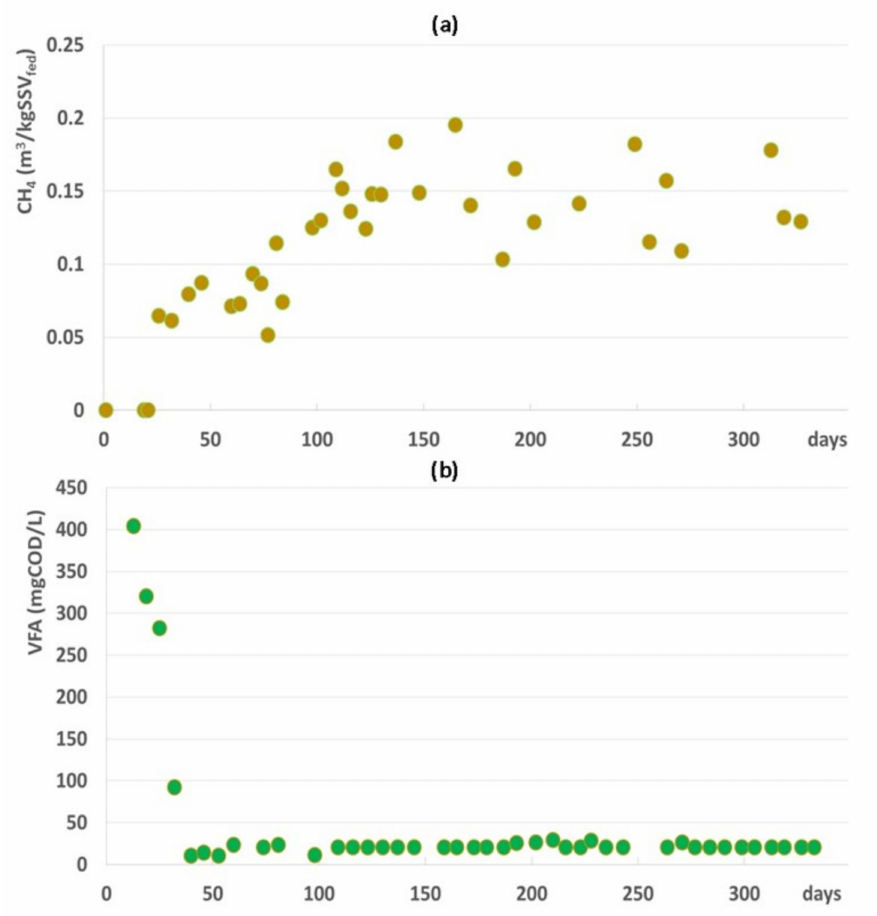
Figure 2. Specific methane production pattern ( a ) and VFA concentration in the digester ( b